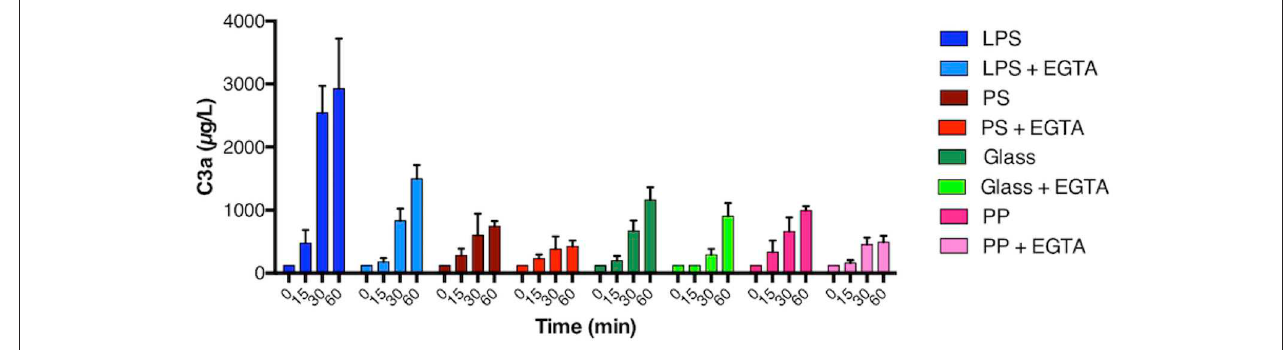
FIGURE 7 | C3a generation after incubation (0–60min) of human lepirudin plasma with different types of surfaces, with and without the addition of Mg 2 + -EGTA.